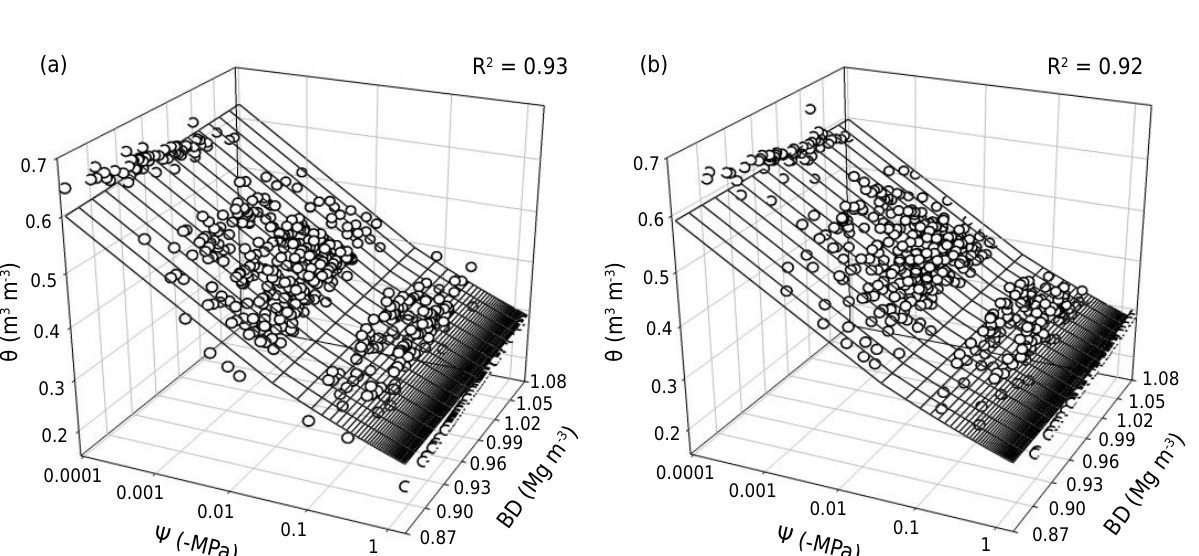
Figure 5. Response surface of water content (θ) as a function of bulk density (BD) and the soil water potential (Ψ) estimated by the function θ = exp(a + bBD) × Ψ c . Surface liming (a) and incorporated liming